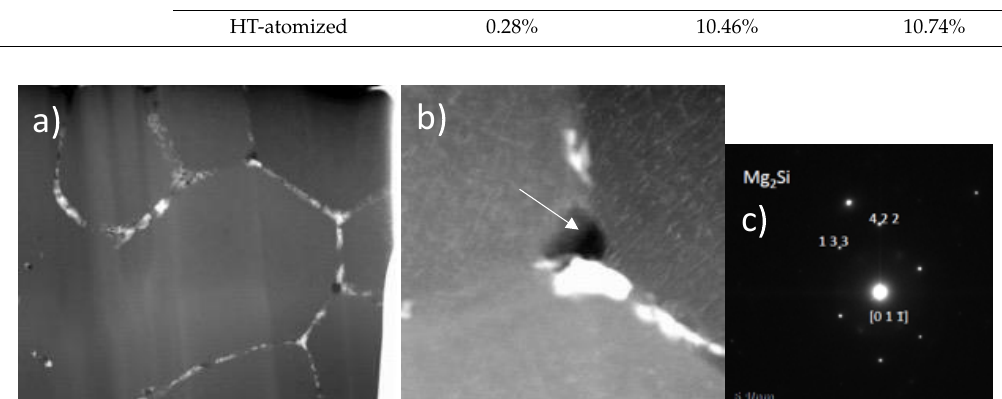
Figure 36: Solubility of alloying elements in aluminum as a function of temperature for Al 6061, showing the maximum solubility at 540 o C.